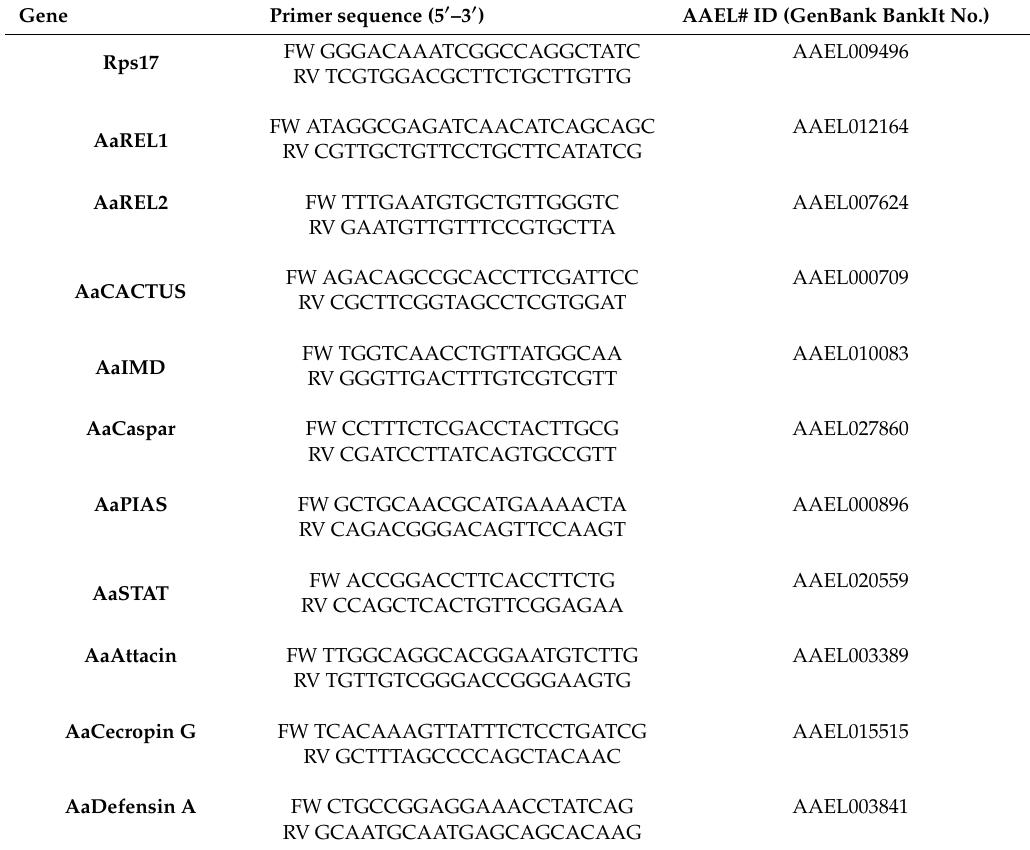
Table 1. Specifications of genes used for RT-qPCR